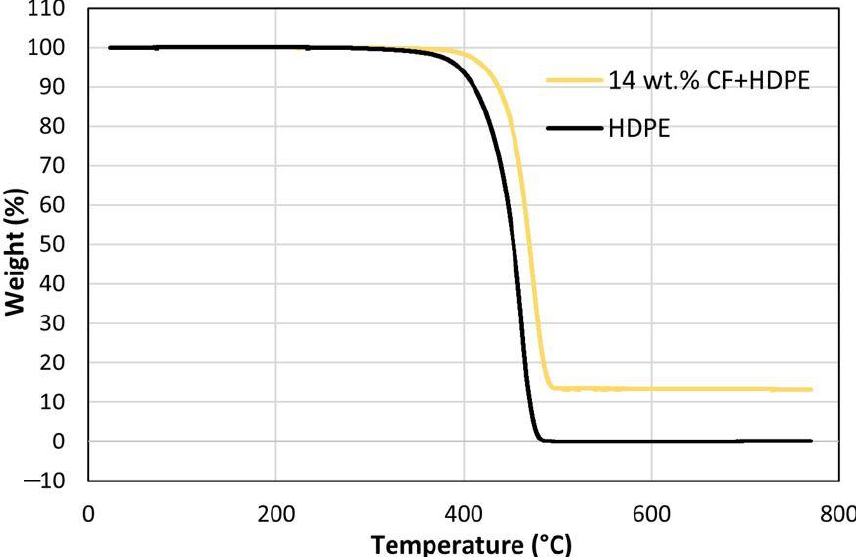
Figure 10. Effects of CFs on thermogravimetric properties.